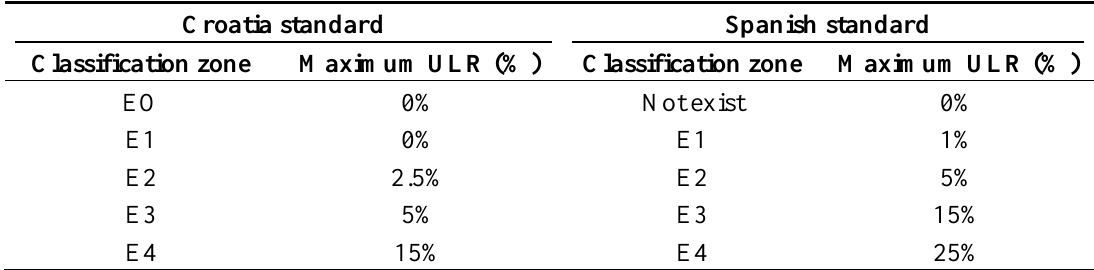
Table 7. Maximum percentage of ULR for Croatia and